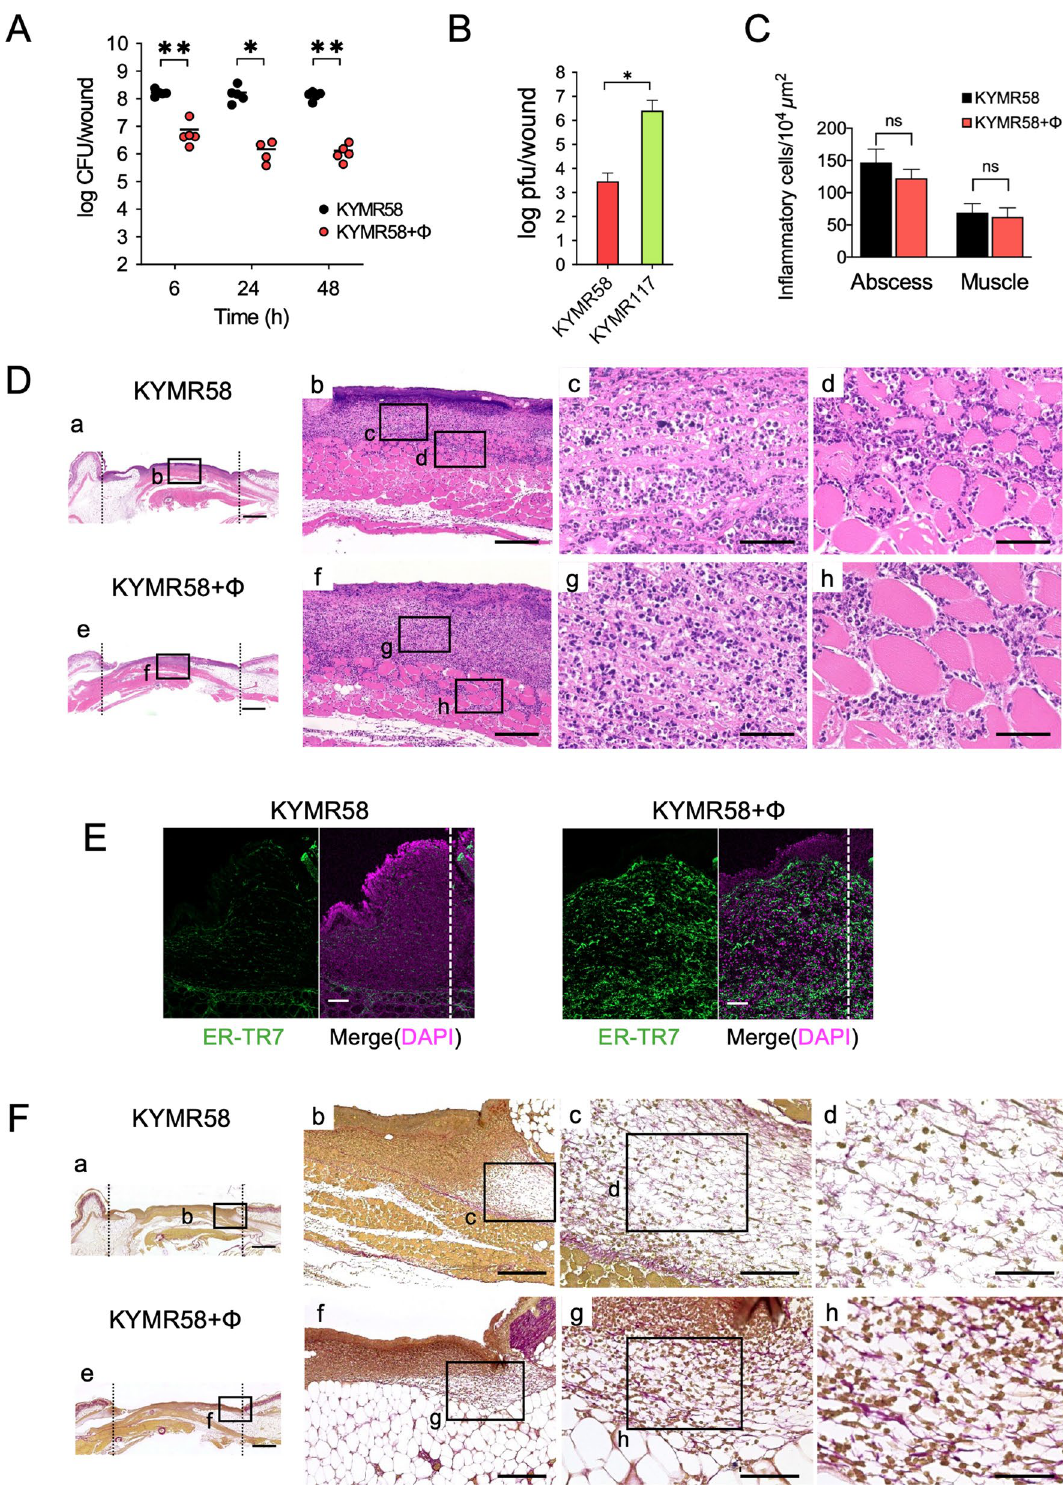
Figure 4. Bacterial loads and histopathological analysis of tissues infected with KYMR58; alone (KYMR58) and with phiRM003 (KYMR58 + ϕ). ( A ) The number of bacteria in the tissue was quantified at 6, 24 and 48 h after infection with KYMR58. The results shown are the mean CFU/wound (n = 4 or 5). ( B ) Phage titre in the tissue infected with KYMR58 and KYMR117 at 48 h after infection. ( C ) The density of the infiltrated inflammatory cells was quantified using three areas randomly chosen in the abscesses. The data show the mean number of cells per 10 4 µm 2 (n = 3). ( D ) Mouse skin tissues observed by haematoxylin and eosin (H&E) staining at 48 h after infection. Data are representative of three mice in each group. Scale bars, 1 mm in a and e, 200 µm in b and f, and 50 µm in c, d, g and h. ( E ) Immunofluorescent micrographs detecting fibroblasts (green) with anti-ER-TR7 antibody. Nuclei were stained with DAPI (magenta). Scale bars, 100 µm. ( F ) Collagen and elastin fibres in the mouse skin were detected by Elastica van Gieson staining. Scale bars, 1 mm in a and e, 200 µm in b and f, 100 µm in c and g, and 50 µm in d and h. The micrographs of a-h in ( D ) and ( F ) are the areas indicated with squares a-h, respectively. Error bars indicate standard errors of the means (SEMs). *, P < 0.05; **, P <